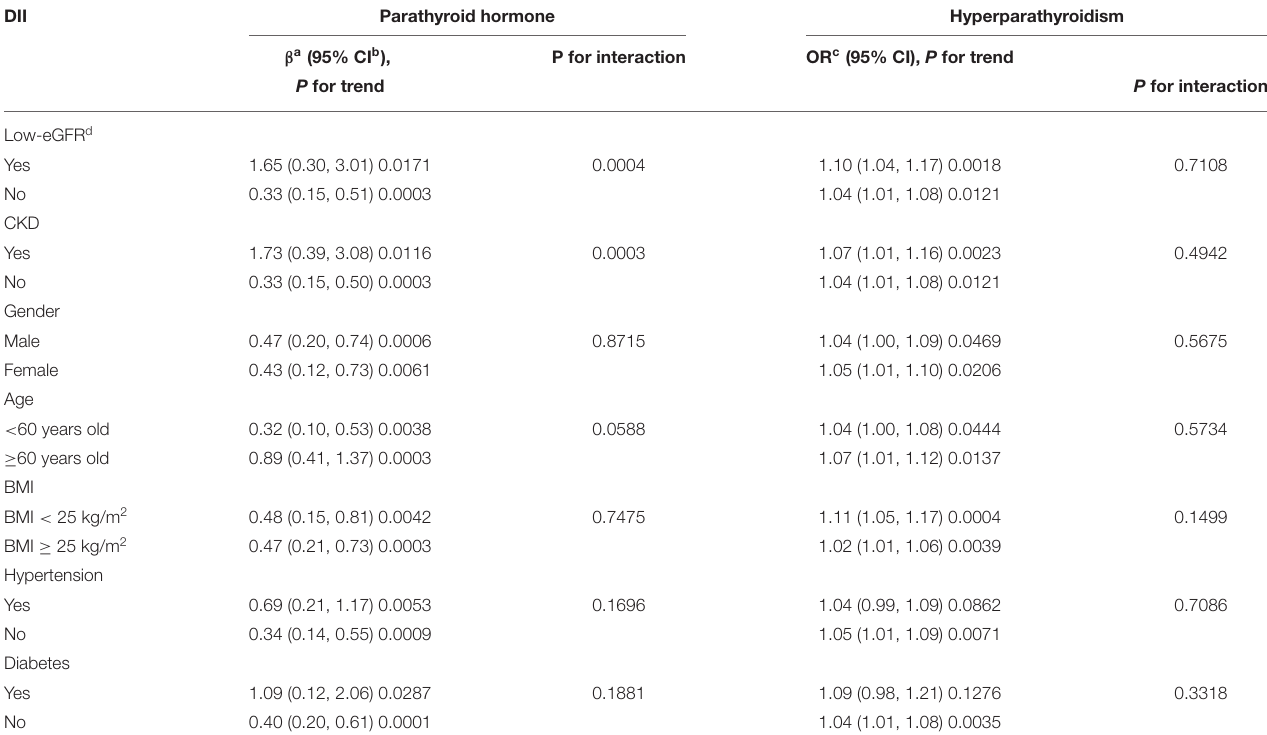
The results show that the subgroup analysis was adjusted for all presented covariates except the effect modifier. eGFR, estimated glomerular filtration rate; CKD, chronic kidney disease. a β : effect sizes. b 95% CI: 95% confidence interval. c OR: odd